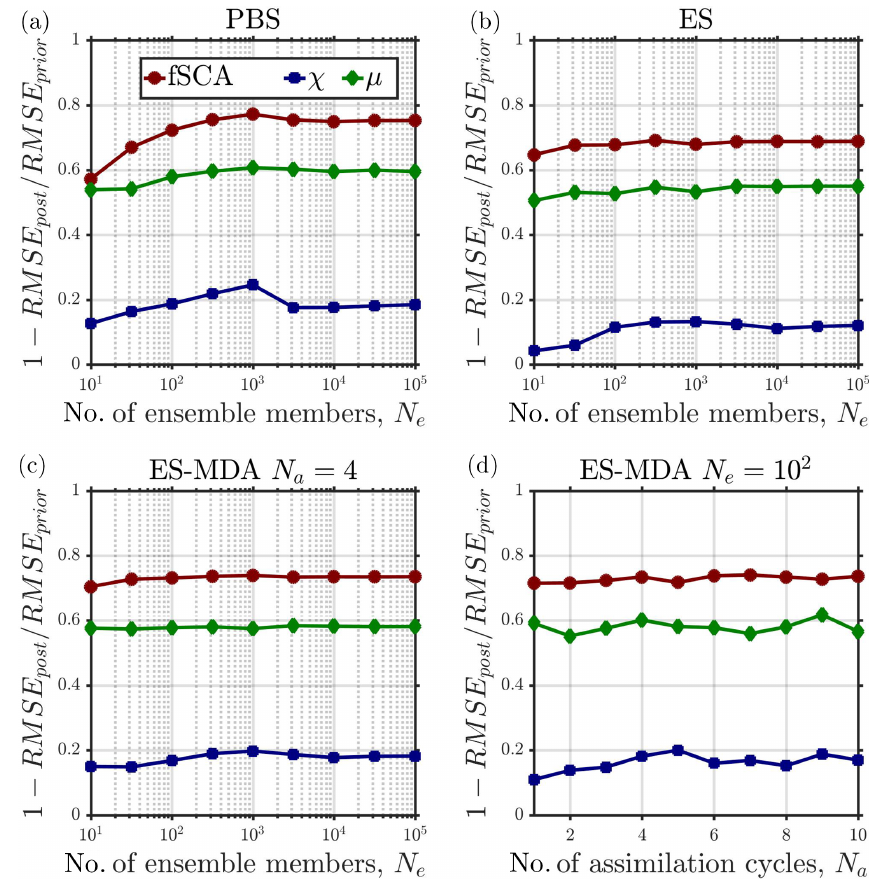
Figure 8. Fractional improvement in RMSE through the analysis step (1 being perfect and 0 no effect) as a function of the number of ensemble members for the fSCA, peak mean SWE µ and coefficient of variation χ ; (a) particle batch smoother, PBS; (b) ensemble smoother, ES; (c) ensemble smoother with multiple data assimilation, ES-MDA; (d) FI as a function of assimilation cycles in the ES-MDA. The FIs for N e ≤ 100 are averaged over 10 2 independent ensemble model integrations. Errors were computed based on comparisons to all the corresponding field measurements presented in Sect.